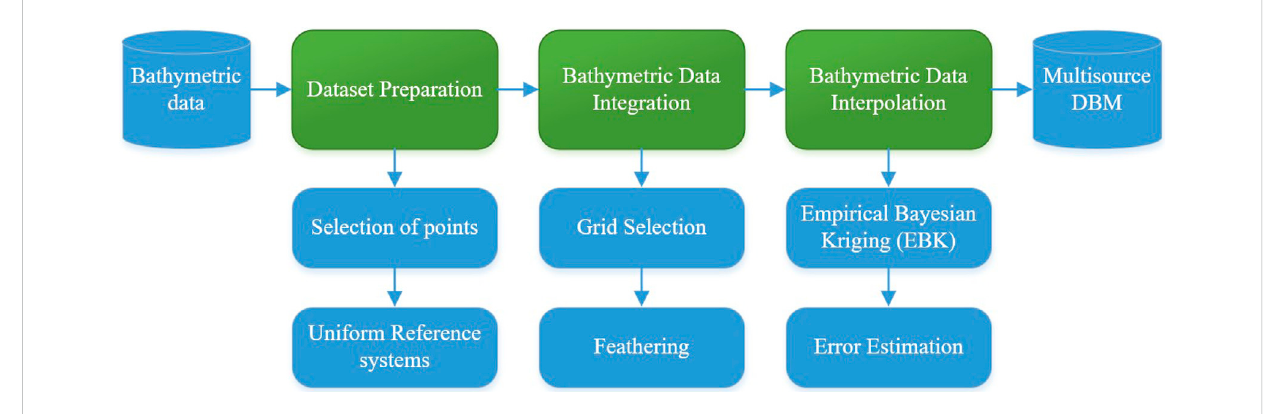
FIGURE 3 Main steps of the proposed integration approach of multisource bathymetric